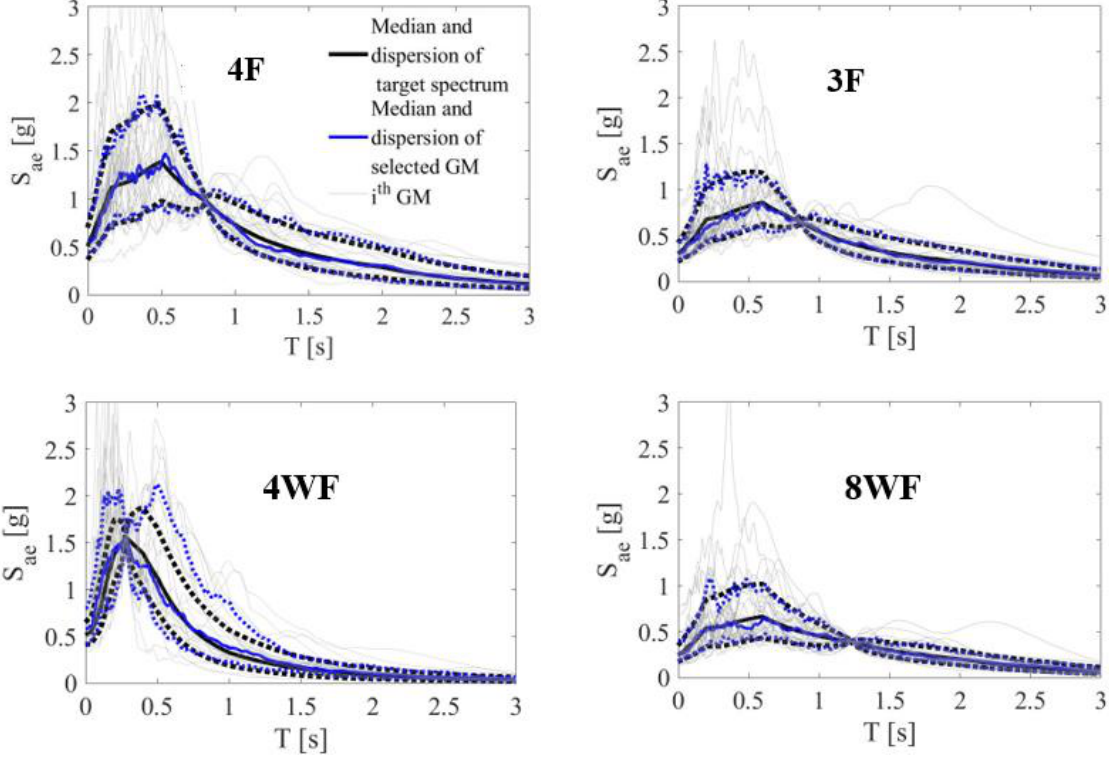
Figure 8. The median, 16th, and 84th percentiles of target conditional spectra, the corresponding spectra of selected ground motions, and spectra of each ground motion selected for the incremental dynamic analysis (IDA) of 4F, 3F, 4WF, and 8WF buildings.